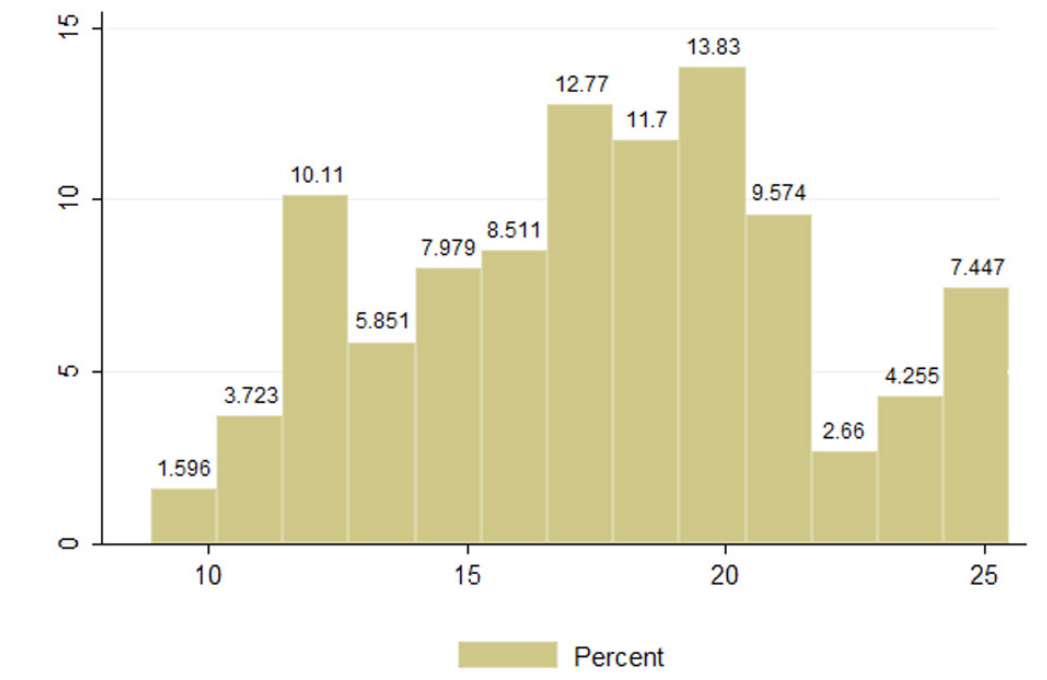
Figure 2. Distribution of EU countries by public spending on social security in